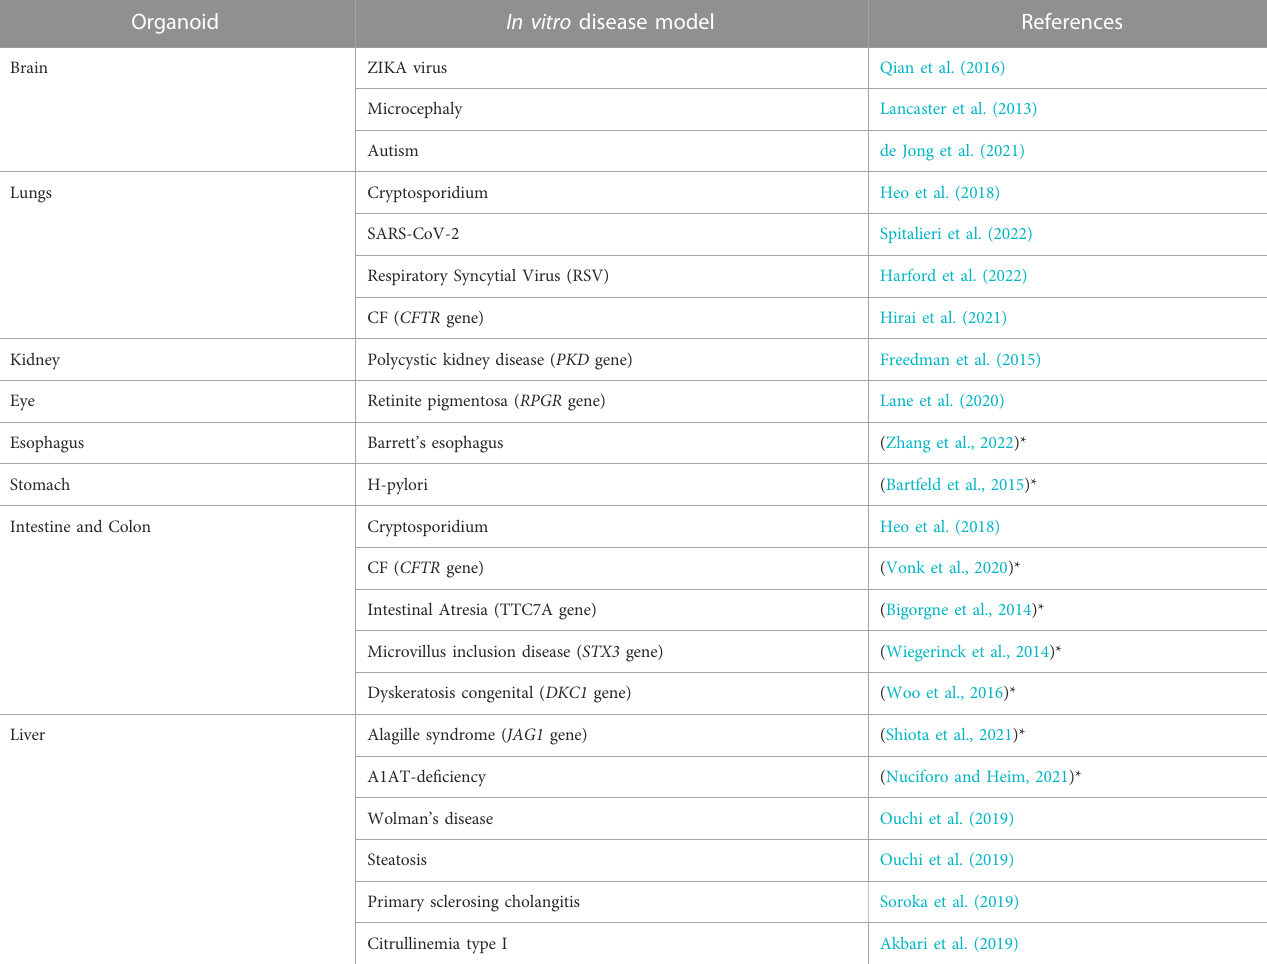
TABLE 1 Examples of hiPSC-derived organoids used to model a speci fi c disease (non-exhaustive list). Organoid In vitro disease model